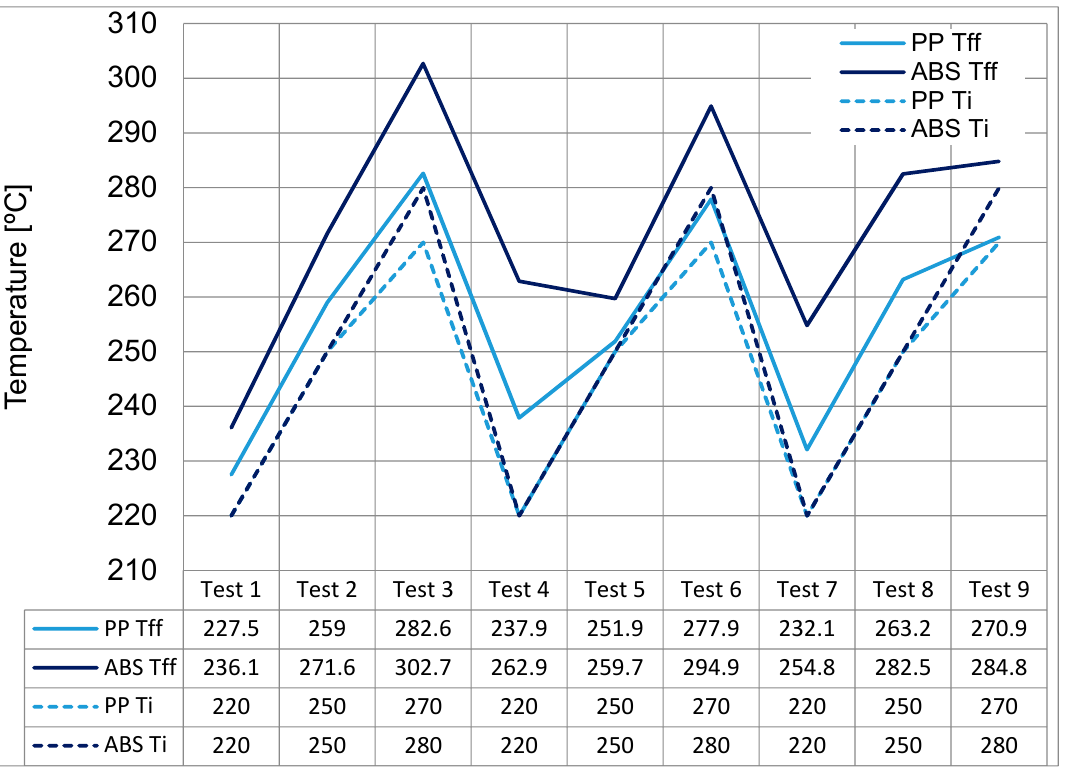
Figure 4. Comparison between T i and T ff on filling for PP and Acrylonitrile butadiene styrene (ABS).